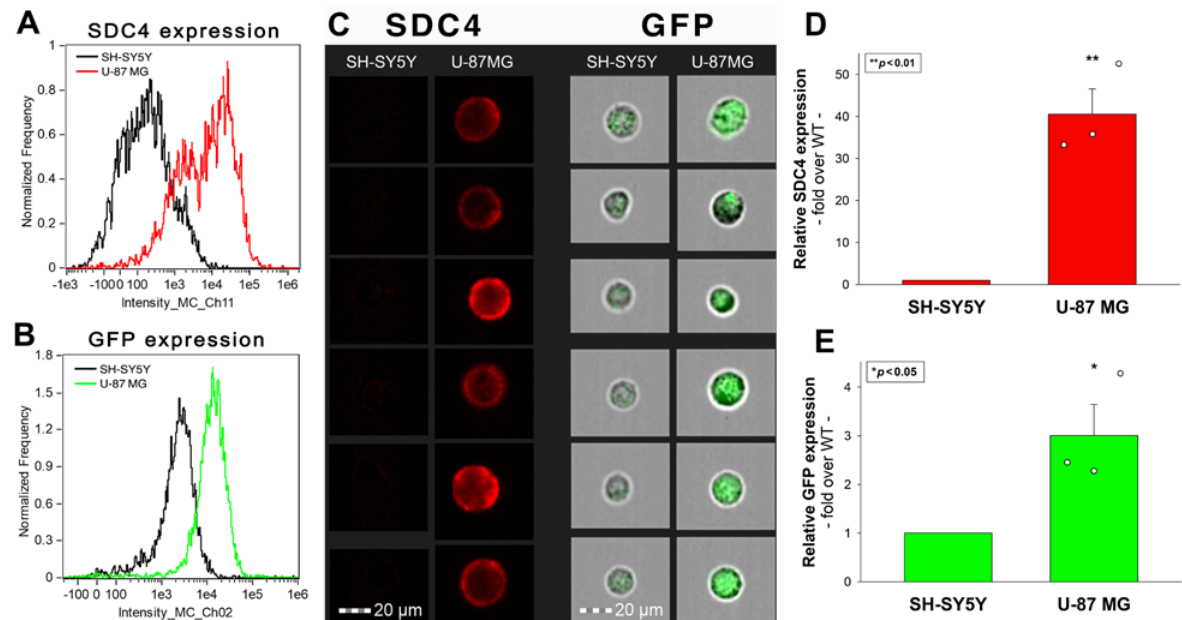
Figure 7. AAV9-mediated GFP transduction is more efficient in U-87 MG than in SH-SY5Y cells. WT U-87 MG and SH-SY5Y cells were incubated with AAV9-GFP (4 × 10 4 vg/cell) for 72 h. GFP expression was then analyzed with imaging flow cytometry. ( A – C ) Representative flow cytometry histograms and fluorescent images showing the SDC4 and GFP expression levels in SH-SY5Y and U-87 MG cells treated with AAV9-GFP. Scale bar = 20 µ m. ( D , E ) Detected SDC4 and GFP expression levels of AAV9-treated U-87 MG cells were normalized to that of SH-SY5Y cells as standards. The bars represent the mean + SEM of three independent experiments. Statistical significance vs. standards was assessed with ANOVA. * p < 0.05; ** p < 0.01.